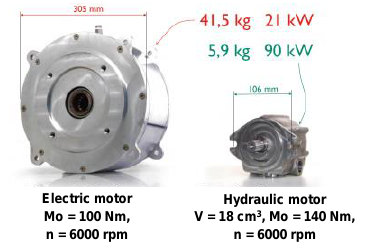
Fig. 8. Technical parameters comparison of electric and hydraulic motors